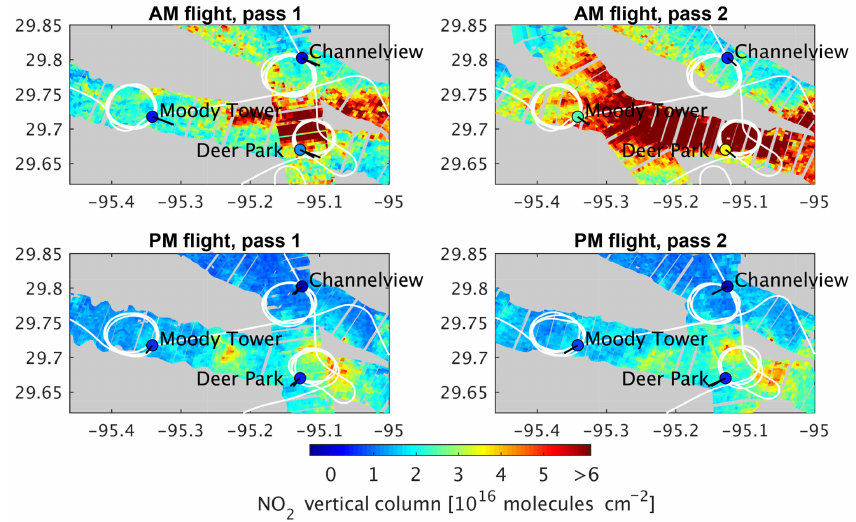
Figure 5. GCAS tropospheric NO 2 columns measured near DISCOVER-AQ ground sites in the area of downtown Houston on 25 September 2013. P-3B flight tracks are shown in white. Pandora direct-sun NO 2 tropospheric columns (total column NO 2 minus modeled NO 2 above the aircraft) are shown in filled circles. Black lines represent the line of sight of each Pandora intersecting the bottom 2km of the atmosphere. The largest NO 2 column observed by GCAS on this day was 16 × 10 16 moleculescm − 2 . The NO 2 precision at this resolution is ∼ 1 × 10 15 moleculescm − 2 . Periodic cross-track gaps in the data are due to write-to-disk intervals of the instrument. During these periods, the instrument does not acquire data, thus producing small gaps in coverage.